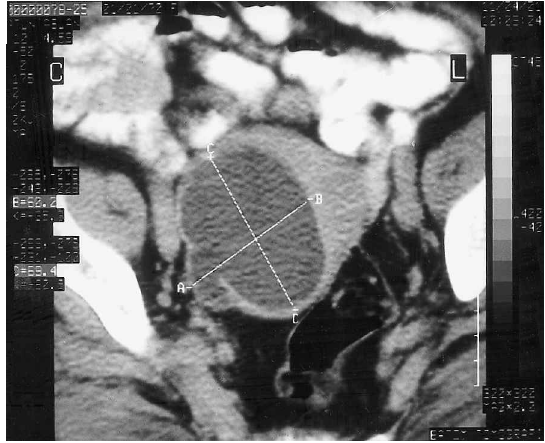
Figure 1 CT image showing a cystic mass within the uterine cavity